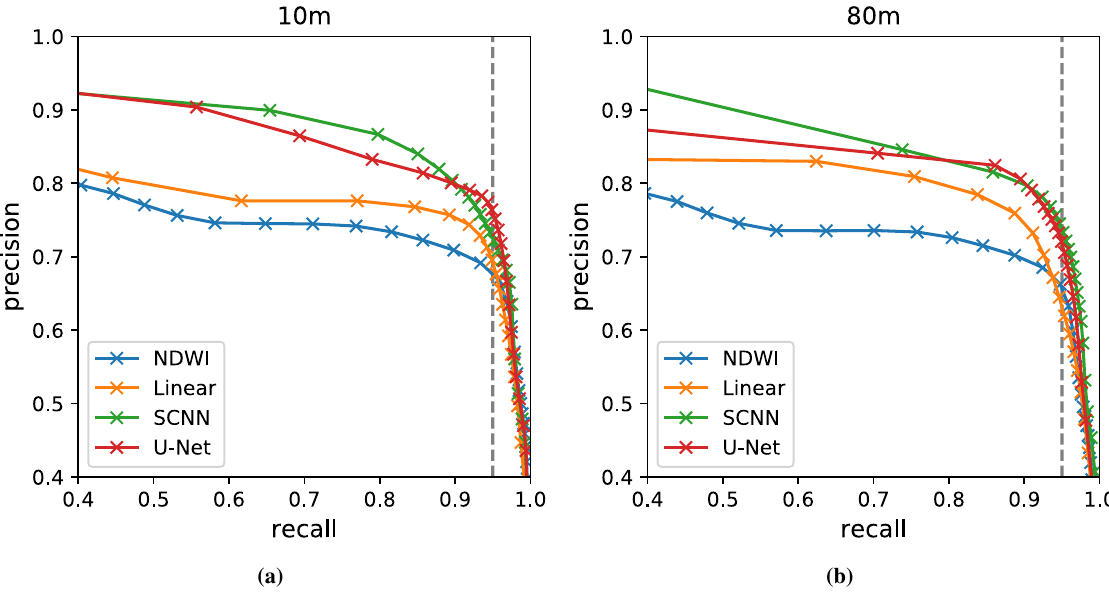
Figure 7. Precision–recall curves of different models trained on ( a ), the Sentinel-2 original resolution (10 m) and ( b ), in the degraded resolution of HyperScout-2 (80 m). In gray 95% recall threshold.